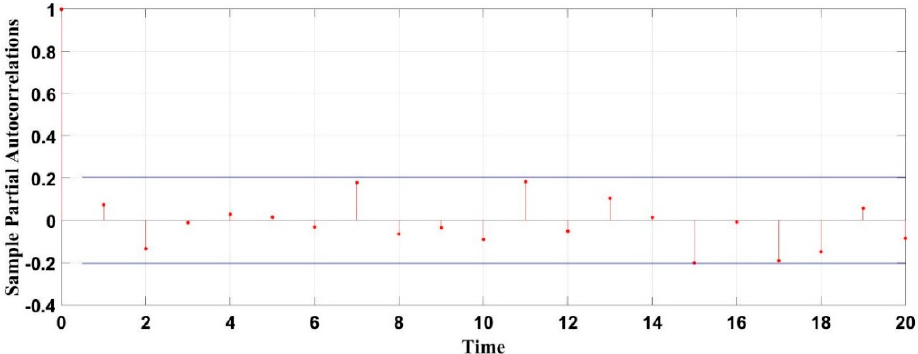
Figure 10. Error diagram of target value and output value.